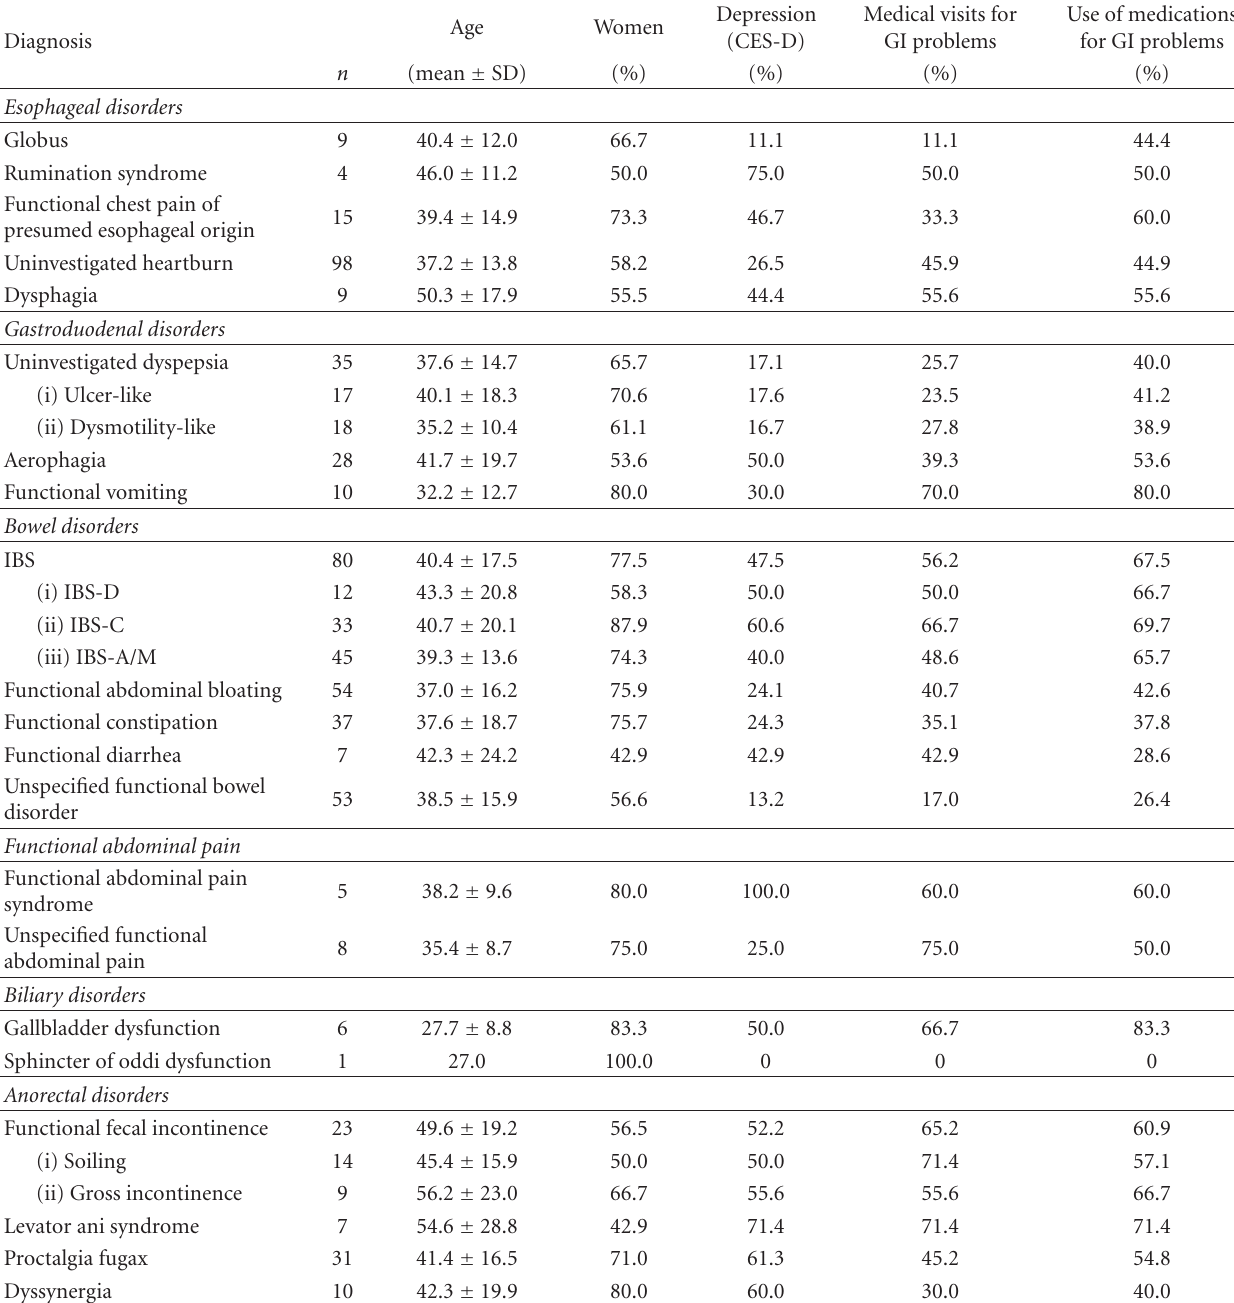
Table 3: Depression, medical visits, and use of medications by